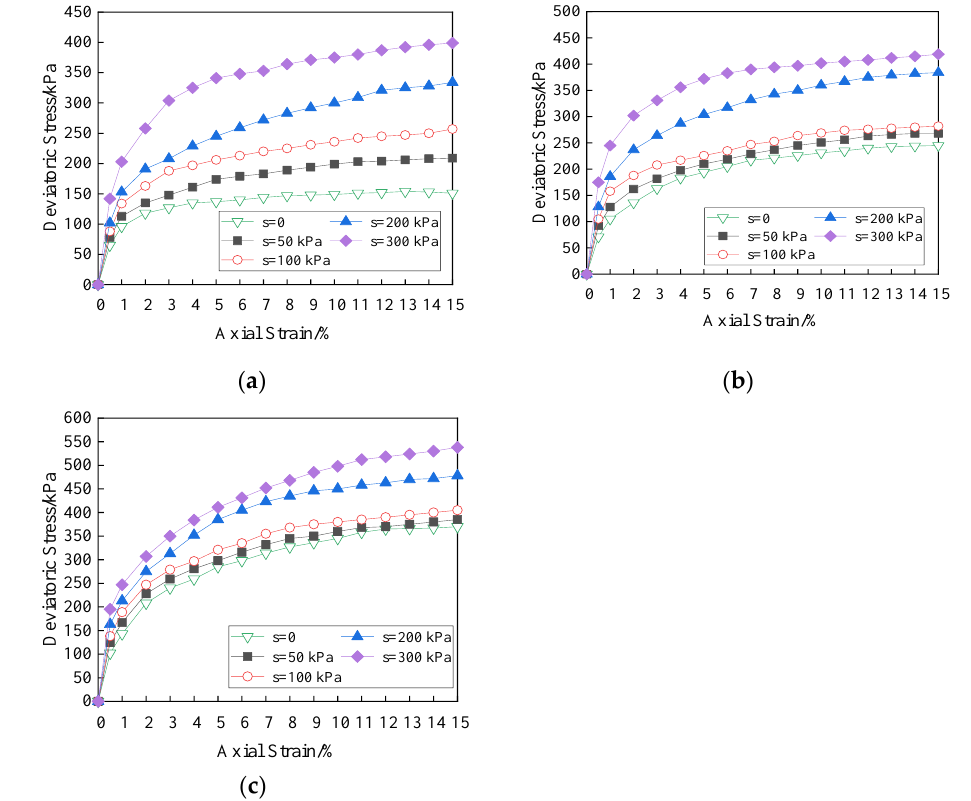
Figure 9. Effects of matric suction on stress vs. strain curves (Fiber length = 12 mm). ( a ) Net confining pressure = 50 kPa, ( b ) net confining pressure = 100 kPa, ( c ) net confining pressure = 200 kPa.